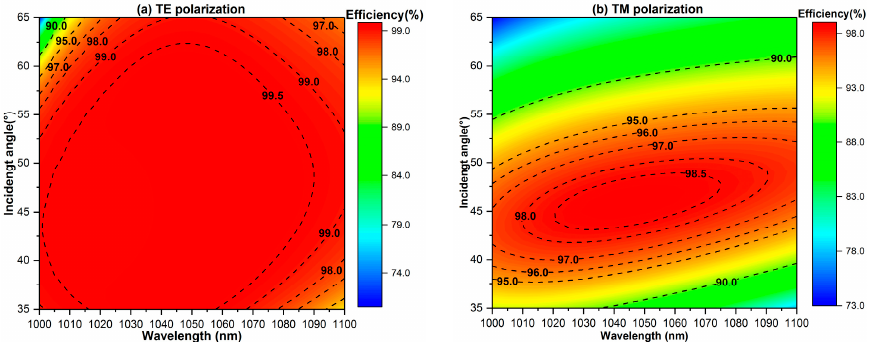
Figure 9. Tolerance analysis of incident angle. − 1st order diffraction efficiency versus incident wavelength and incident angle for TE and TM polarizations.